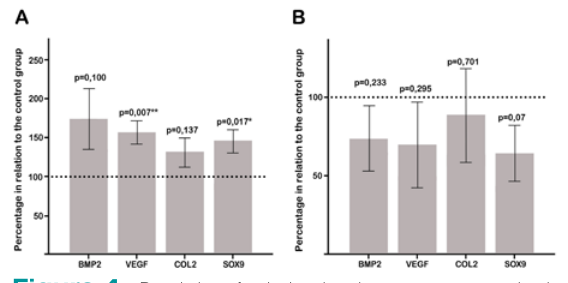
Figure 4. Regulation of articular chondrocyte gene expression by biomechanical loading; (A) 4 hours, (B) 24